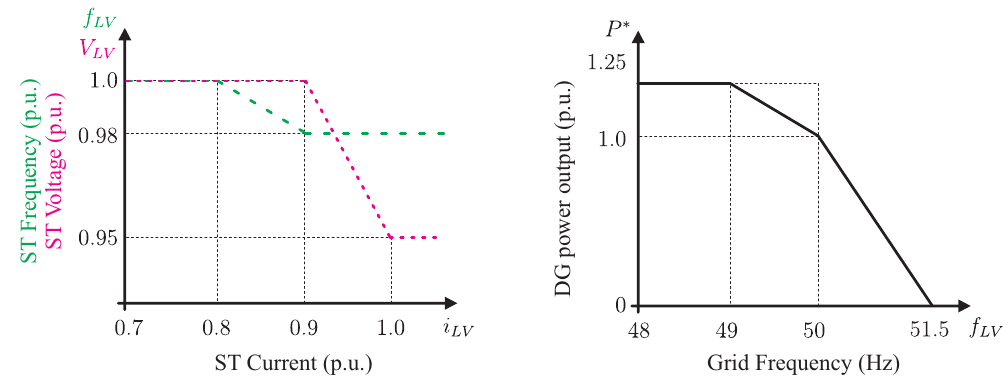
Figure 3. ST overload controller and DG (Distributed Generation) droop controller.